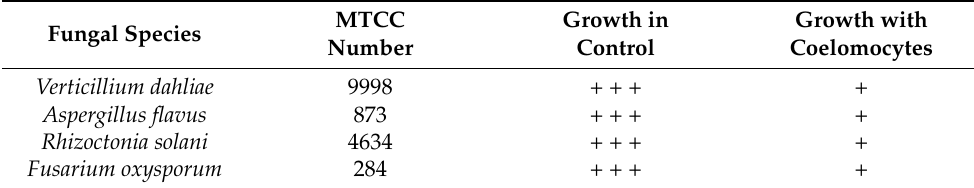
Table 2. The effect of CF of earthworms on growth rate of fungal hyphae (adopted from Rajesh et al., 2019) [39].